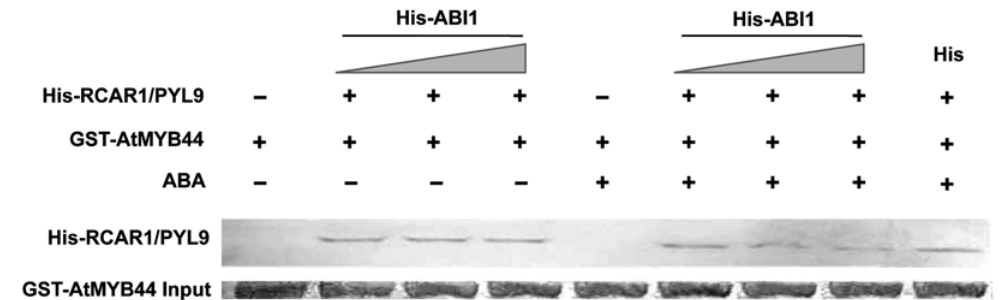
Figure 4. AtMYB44 competes with ABI1 for binding to RCAR1/PYL9 in vitro . His-RCAR1/PYL9 was pulled down with GST-AtMYB44 or GST in the absence or presence of His-ABI1 (or His). The gradient indicates increasing amount of His-ABI1. The immune-precipitated fractions were detected by western blotting with anti-His antibody ( upper panel ). GST-AtMYB44 input is shown in the lower panel . When indicated, the medium was supplemented with 10 μM ABA. Three independent experiments were performed and similar results were